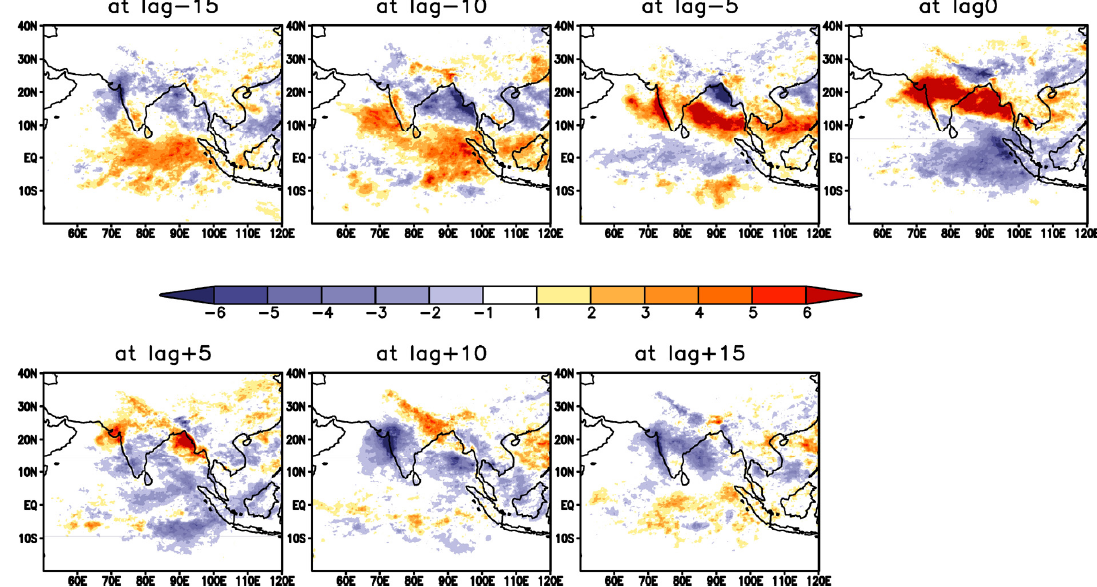
Fig. 3. Lag composite of rainfall (mmday − 1 ) during active spells based on CIPI using TRMM 3B42 data for the period 1998–2008.